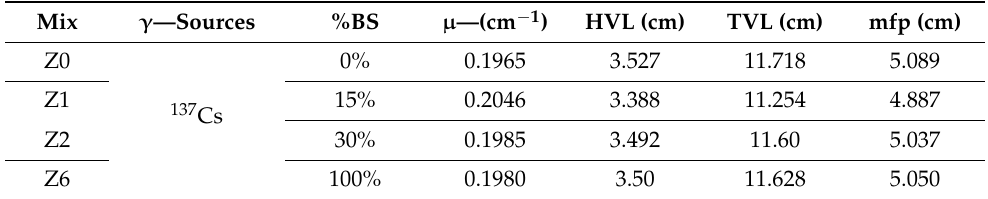
Table 3. The HWHPC radiation shielding